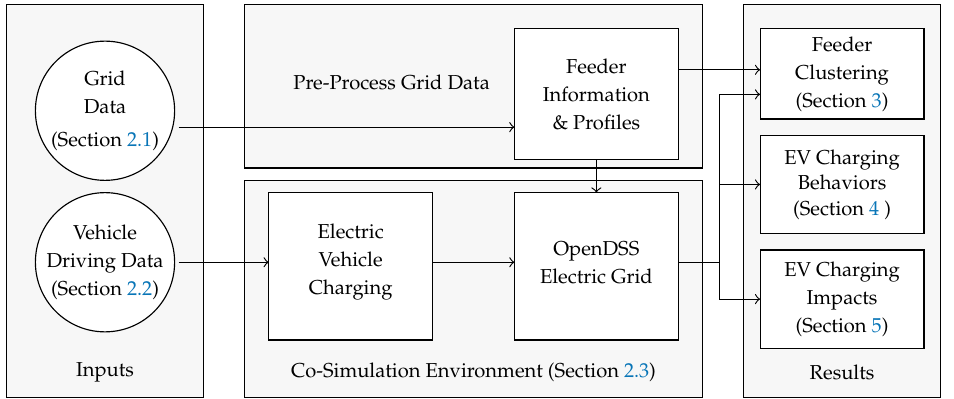
Figure 1. The block diagram describes the experimental process that began with grouping the feeders based on load data. A co-simulation environment emulated electric vehicle (EV) charging and EPS power flows. The simulations used grid and vehicle driving data as inputs. The grid data and simulation results output demand profiles and feeder performance for distribution EPS supporting various types of loads and EV adoption